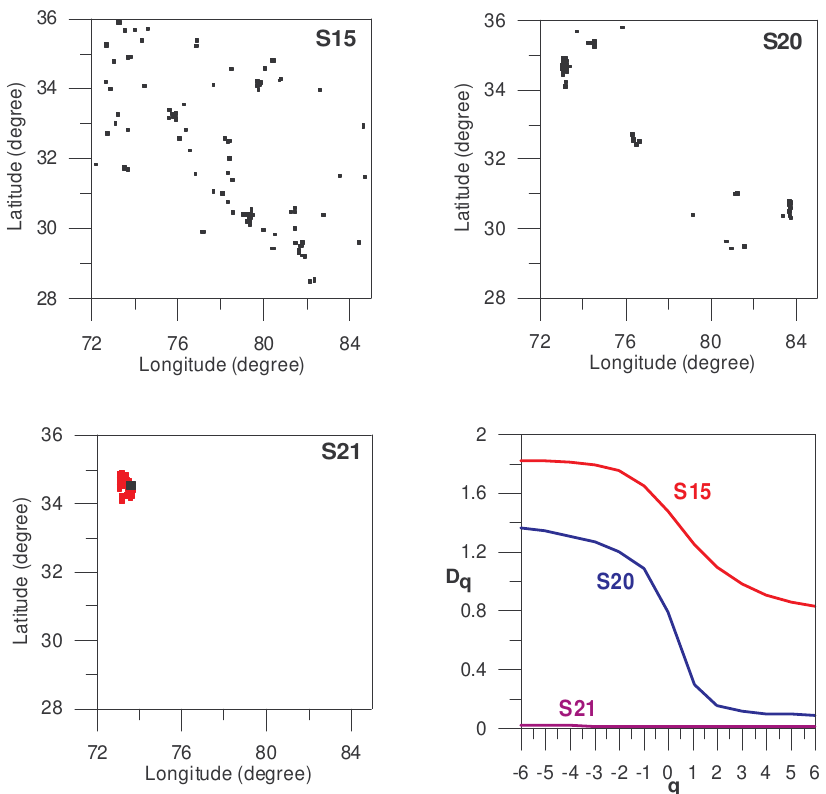
Fig. 5. The seismicity of subsets S15, S20 and S21. The Muzaffrabad-Kashmir earthquake of October 2005 lies in subset S21. The corre- sponding D q − q spectra of these subsets are also